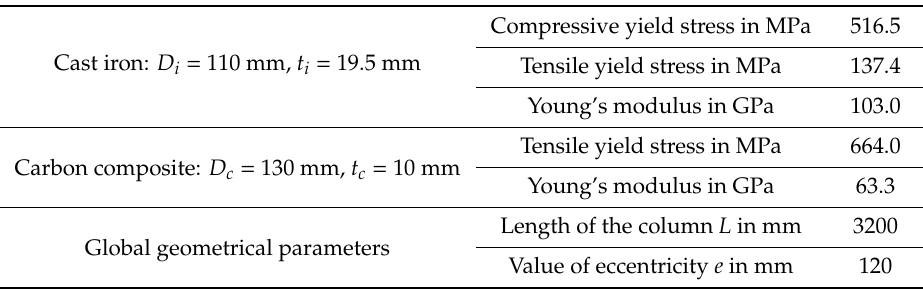
Table 1. Geometrical and material